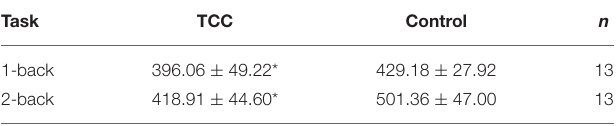
TABLE 2 | N-back task RTs of participants (M ±